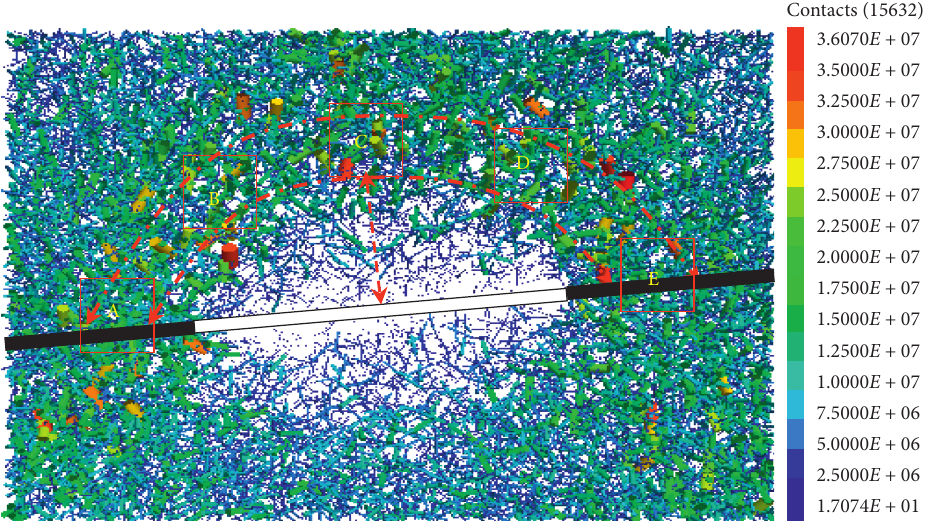
Figure 10: Distribution characteristics of the inclined force chains within the surrounding rock masses of the